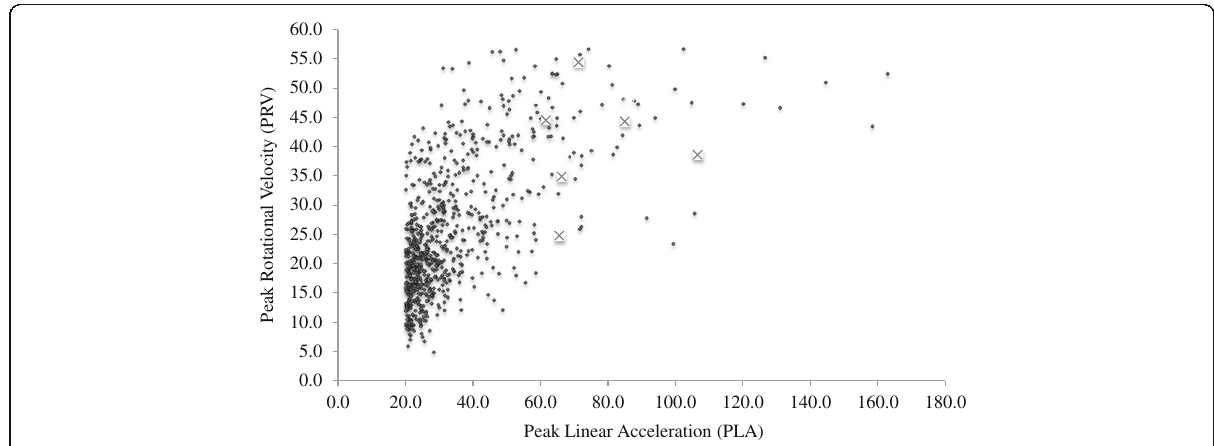
Fig. 2 Scatterplot of video-verified impacts recorded by the x-patch ™ . X: medically diagnosed concussion